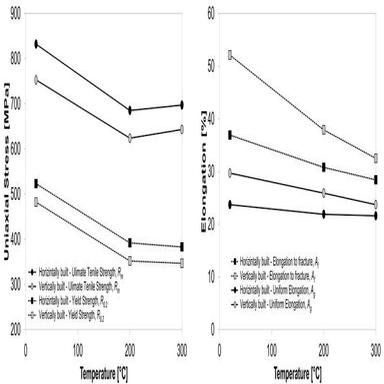
Relationship of uniaxial properties vs. temperature for heat treated LPBF DSS2205 across two build orientations (a) R0.2 and Rm (b) Ag and Af.